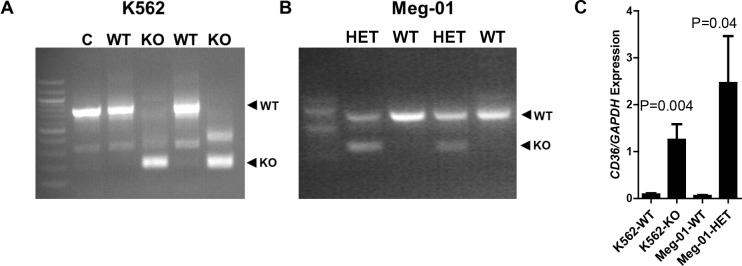
Deletion of the rs2355739-rs1194196 locus increased CD36 expression.Deletion of the rs2355739-rs1194196 locus in (A) K562 and (B) Meg-01 cells by CRISPR/Cas9 was validated by PCR using primers flanking the deleted section. WT clones did not contain a deletion while KO clones contained the deletion. (C) qRT-PCR of CD36 mRNA indicated that the wildtype (WT) K562 and Meg-01 clones contained less CD36 RNA than KO clones lacking the rs2355739-rs1194196 locus (KO).